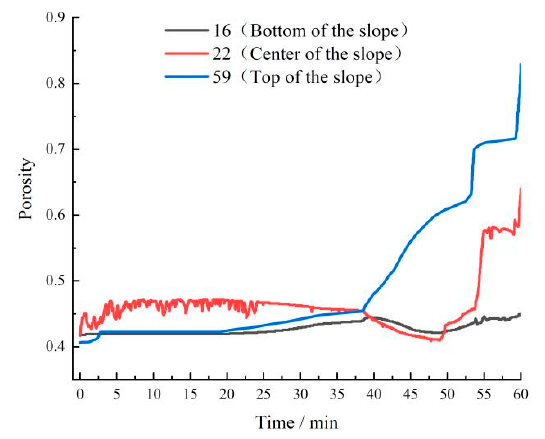
Figure 14. Variation in porosity in No. 3 gully with time.